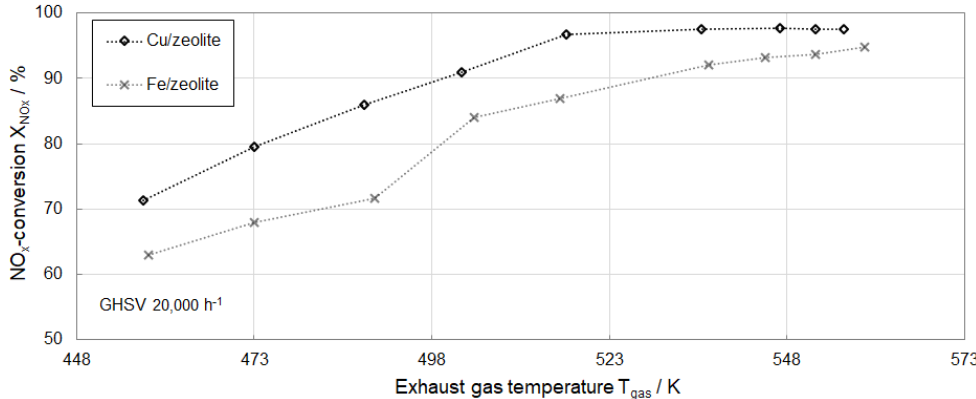
Figure 2. Comparison of conversion rates of two different SCR converters.